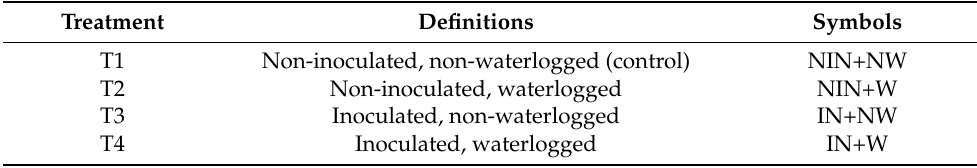
Table 1. Definitions of the evaluated treatments. Treatment